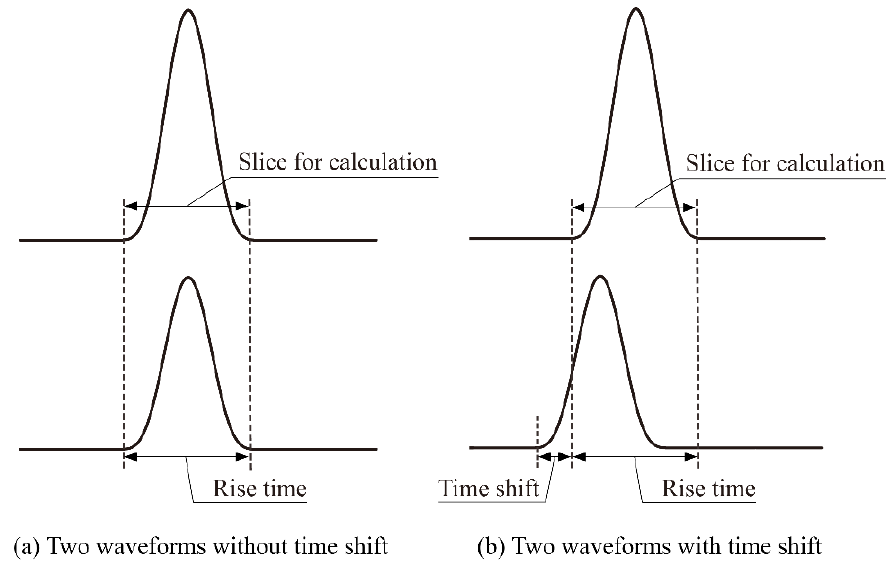
Figure 9. Time shifts between correlation functions of raw waveforms and signals.